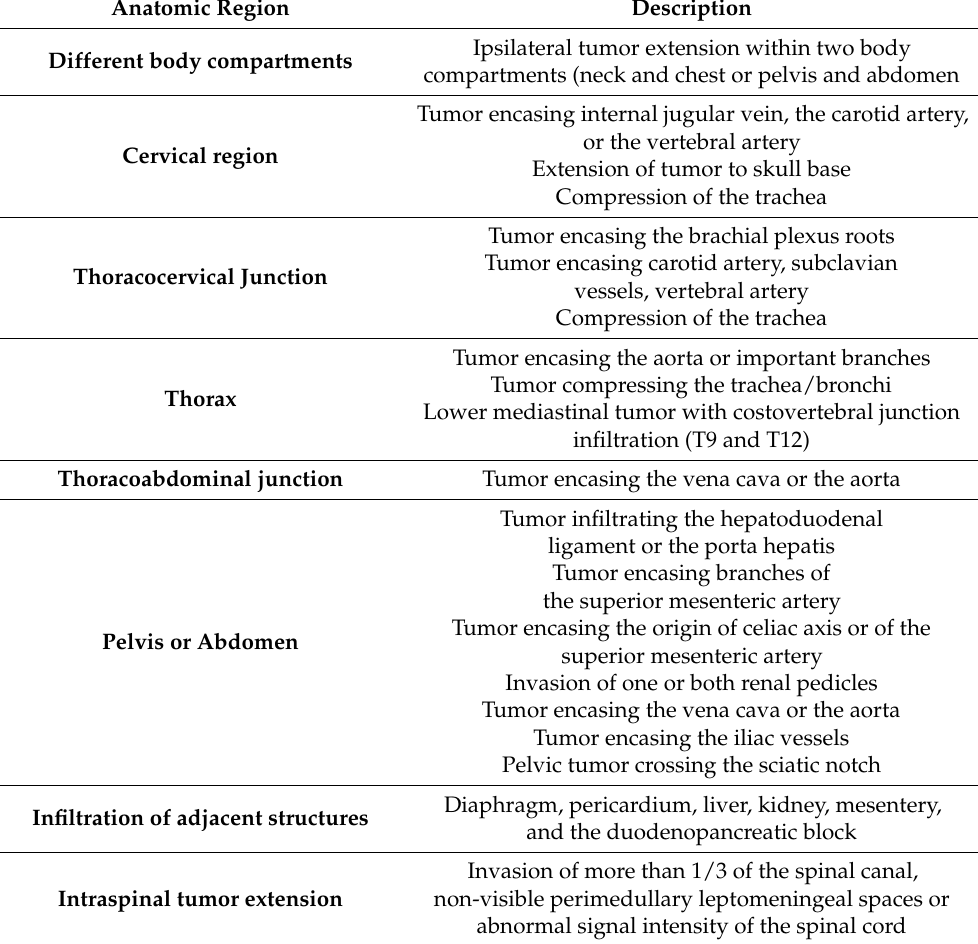
Table 1. Definitions of image-defined risk factors (IDRF groups)